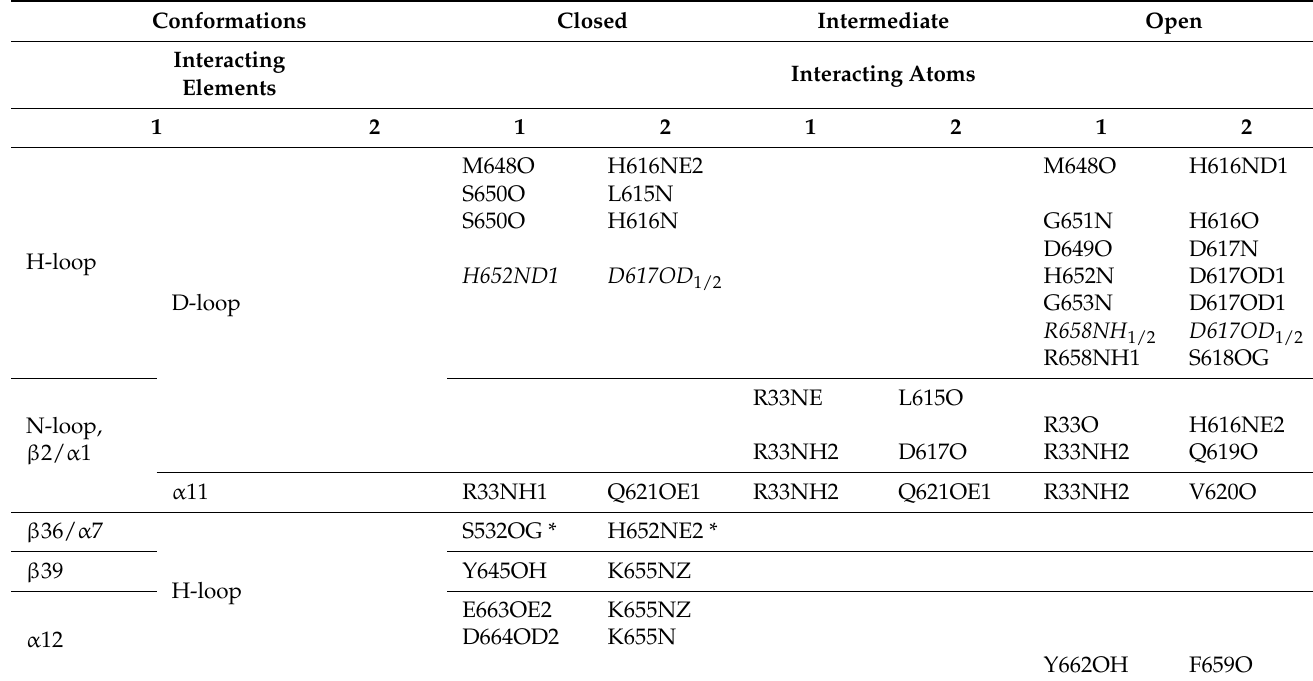
Table 3. Polar contacts connecting D- and H-loops to each other and to other structural elements of the catalytic domain in the three states of